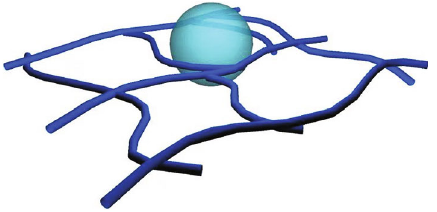
Figure 1: The sketch map of the hydrogel